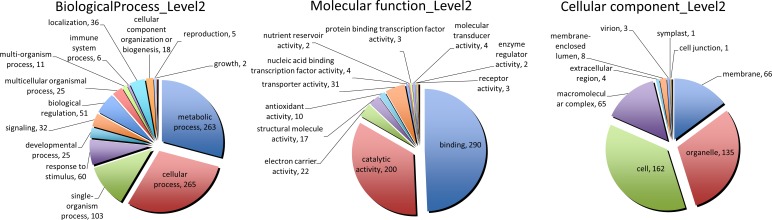
Distribution of GO terms association of the annotated class TCONS transcripts.For the three ontological domains (C: cellular component; F: molecular function; P: biological process), the pie chart reports the number of GO terms in the different categories.